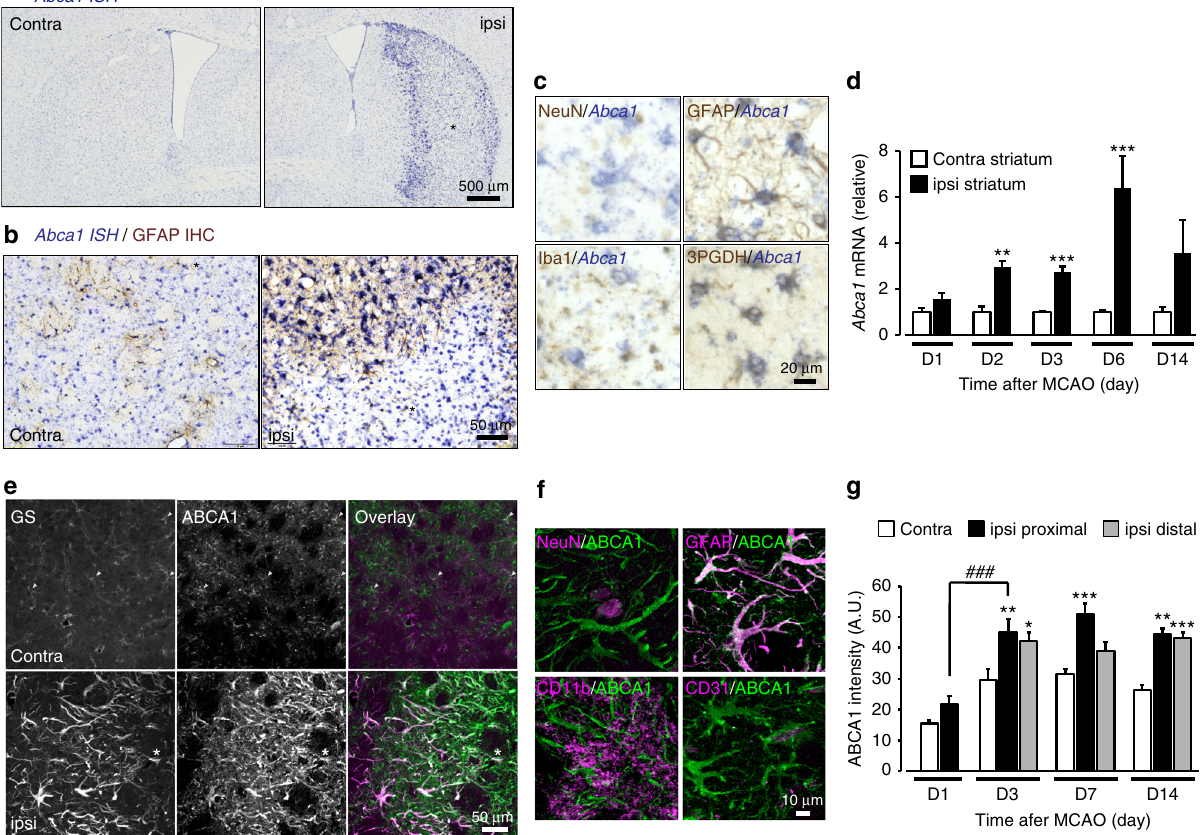
Fig. 6 Transient ischemic injury induces ABCA1 upregulation exclusively in reactive astrocytes. a In situ hybridization (ISH) analysis of Abca1 mRNA at 7 days after MCAO. Abca1 ISH signals ( purple ) are strongly upregulated in the ischemic penumbra. b Representative images show that increased Abca1 ISH signals colocalize with GFAP immunoreactivity (DAB: brown ). c Increased ABCA1 ISH signals colocalize with GFAP and 3PGDH, but not with NeuN and Iba1 in the ischemic penumbra at 7 days after MCAO. Low-magni fi cation images from the contralateral side are shown in Supplementary Fig. 6b. d Real-time PCR analysis of Abca1 mRNA in total RNA extracted from the ipsilateral and contralateral striatum after MCAO. Values represent the relative ratio of Abca1 mRNA (normalized to GAPDH mRNA levels) to the corresponding contralateral striatum (D1: n = 4; D2: n = 3; D3: n = 8; D6: n = 9; D14: n = 6; * P < 0.05 , ** P < 0.01, *** P < 0.001 vs. contra (corresponding day)). e Immunostaining for ABCA1 and GS in the contralateral and ipsilateral striatum at 7 days after MCAO. Fifteen images per z-stack image (1.14 µ m step). f Increased ABCA1 IHC signals colocalize with GFAP, but not with NeuN, CD11b, or CD31 in the ischemic penumbra at 7 days after MCAO. g Quanti fi cation of ABCA1 immunoreactivity mean intensity in GS + astrocytes after MCAO ( n = 9, 8, 12, 12, 21, 11, 12, 20, 12, 11, 21 fi elds, 3 – 4 mice, * P < 0.05, ** P < 0.01, *** P < 0.001 vs. contra (corresponding day), ## P < 0.01 ipsi proximal D1, one-way ANOVA (P < 0.0001) with Tukey ’ s multiple comparison test). Asterisks indicate the ischemic core. Values represent means ±